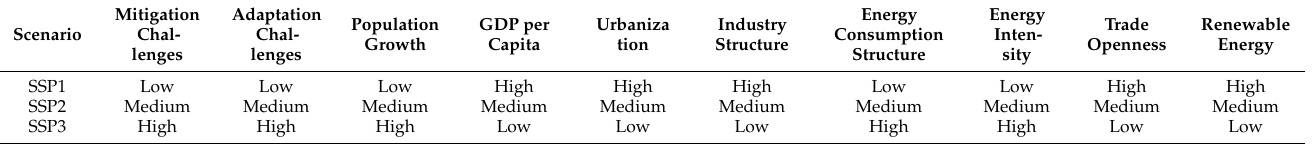
Table 3. The three SSP scenarios